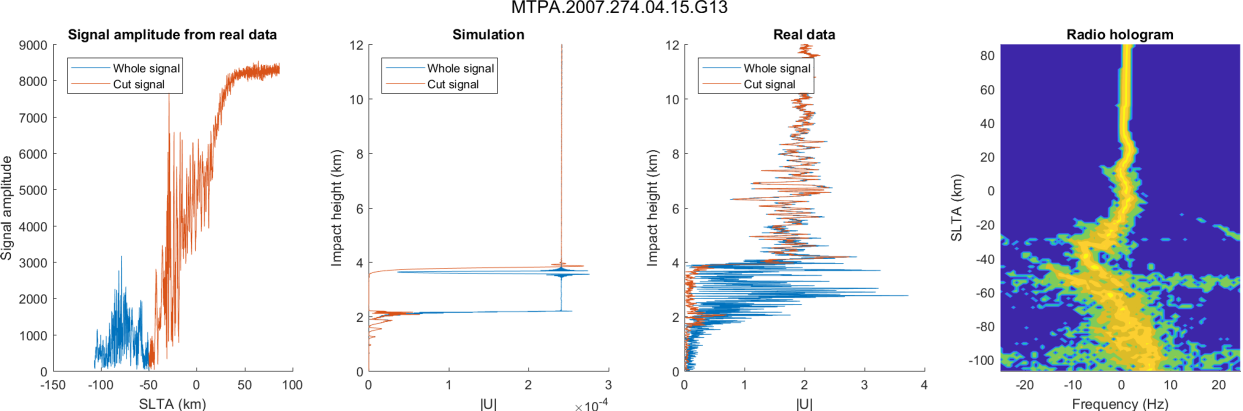
Figure 9. An event classified as category 3. SLTA min is at approximately − 84km, and the signal is truncated at SLTA = − 50km. The reflection spike is located at an impact height of 2057m, and a min is 2182m.